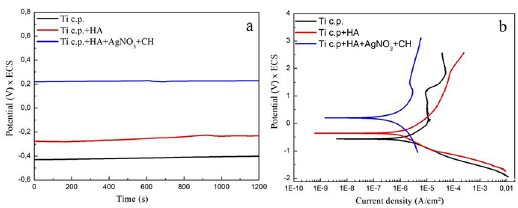
Figure 7. Assay of cp-Ti corrosion in 1.5 SBF at 36.5ºC. (a) assay of open circuit potential (OCP). (b) assay of linear